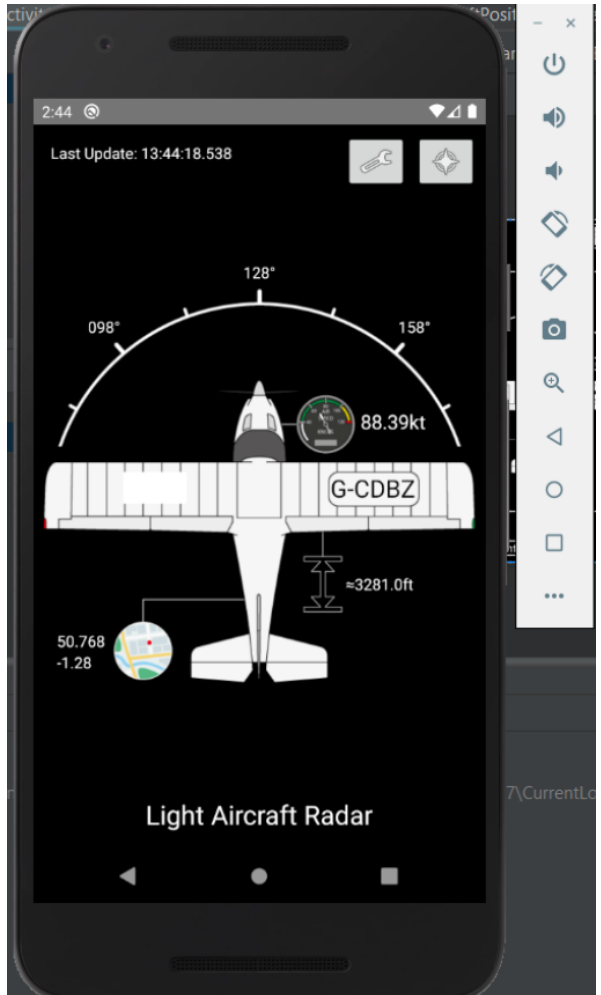
Figure 9. An Android Emulator of a Nexus 5X running the mobile